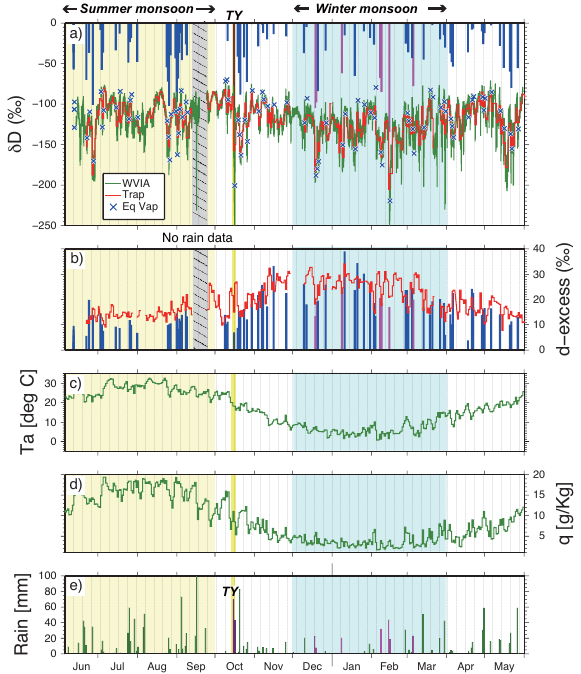
Figure 3. Time series of isotopic values and surface meteorological variables at Nagoya in Japan for the period of June 2013 to June 2014 (summer: shaded in light yellow; winter: shaded in sky blue). (a) δ D in precipitation (bar) and surface vapor measured by the laser instrument (green line) and by the conventional cold trap method (red line). The black cross represents the calculated δ D of vapor in isotopic equilibrium with precipitation at surface air temperature. The pink-colored bars represent rainfall from Nangan cyclones. (b) The d-excess in precipitation and surface vapor measured by the cold trap method. (c) Air temperature, (d) mixing ratio and (e) precipitation observed at the nearest meteorological station. The “TY” at the top of the figure corresponds to the passage of a typhoon at the observation